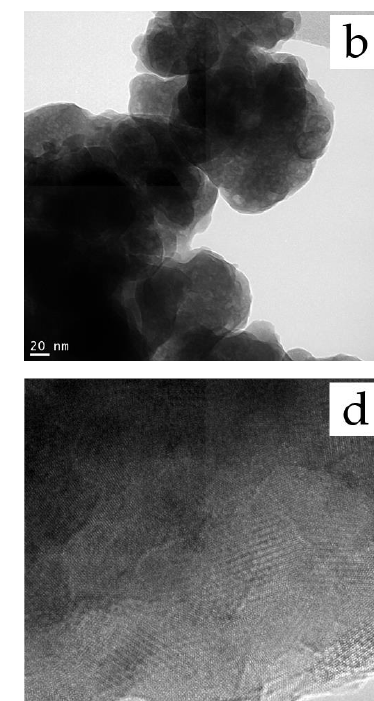
12 Figure 6. Distribution map of elements across particles in 2.0-ZnSi-HA sample. Data obtained by TEM measurement.